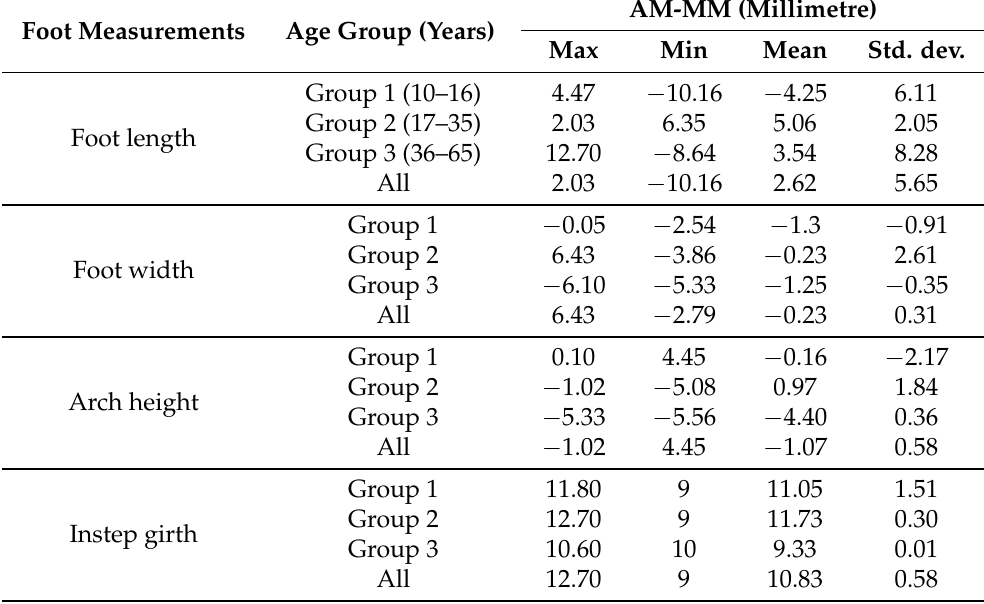
Table 3. Difference between the application-based measurement (AM) and the manual measurement (MM) of all foot dimensions. All measurements are in millimetres (mm).